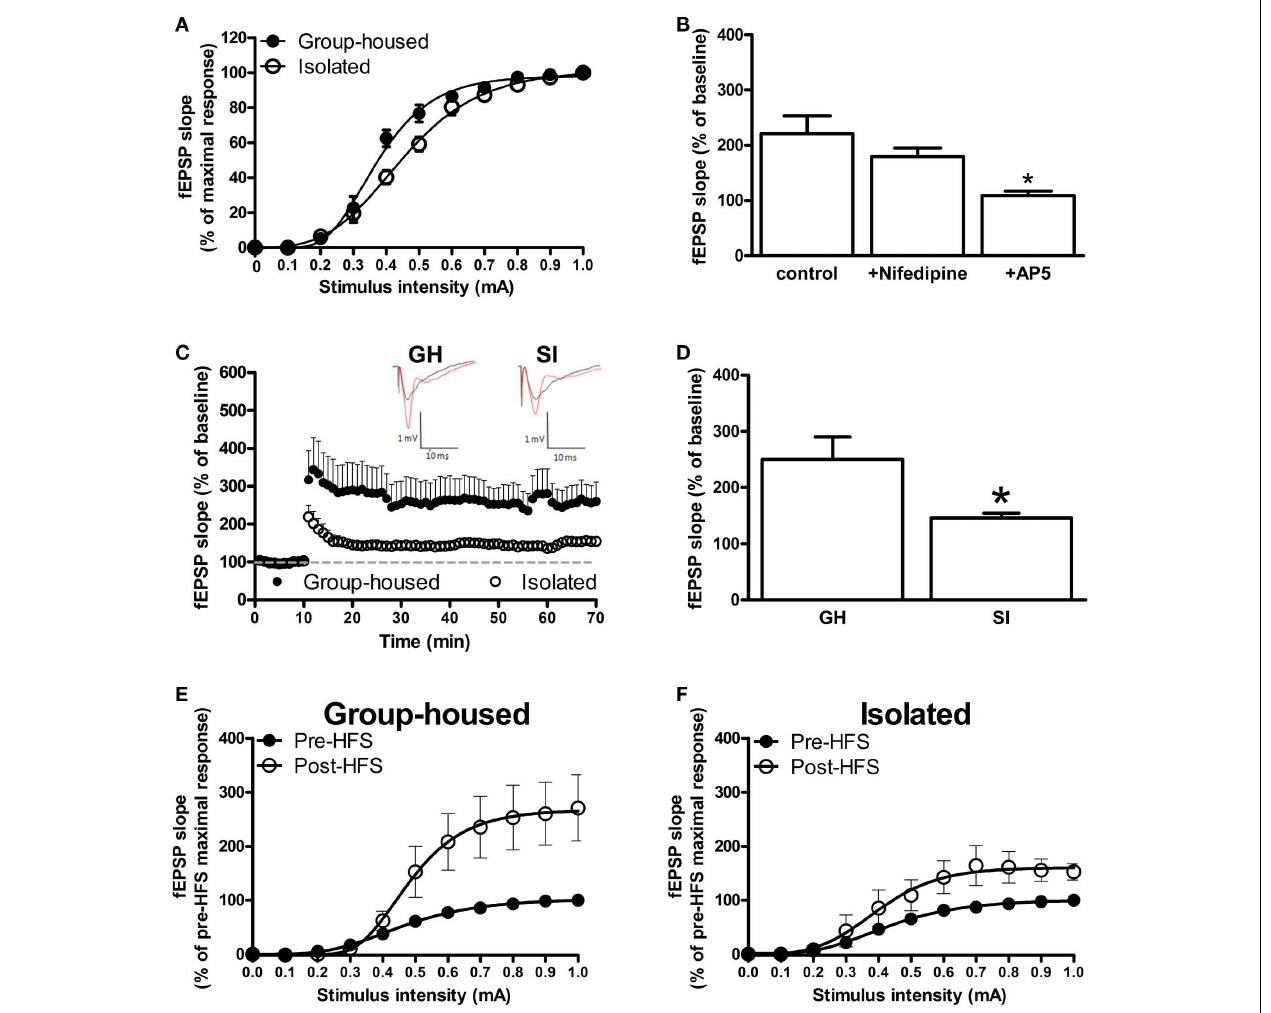
HFS) of the NMDA receptor antagonist AP5 (50 μ M). (C) LTP was induced in the CA1 region by HFS (arrow) of the Schaffer collateral–CA1 pathway. Data represent fEPSP slope at the indicated times expressed as a percentage of that at baseline and are means ± SEM ( n = 8–12 slices). Above the bar graph, representative traces of fEPSPs obtained from GH and SI mice before (black trace) and 50min after (red trace) high-frequency stimulation (HFS). (D) The extent of LTP was calculated by averaging the change in fEPSP slope apparent between 50 and 60min after HFS. Data are means ± SEM ( n = 8–12 slices). * p < 0.05 vs. GH mice. (E,F) I–O relations before and 60min after HFS in GH (E) and SI (F) mice. Data are expressed as a percentage of the maximal response measured before HFS and are means ± SEM ( n = 8–12